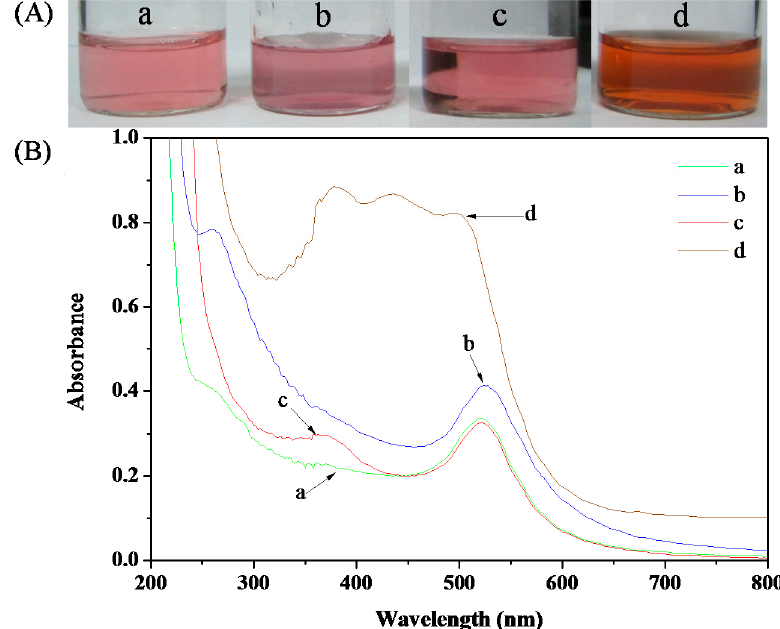
Figure 6. Colorimetric response of the sensor: ( A ) color changes and ( B ) absorption spectra of (a) 1.2 nM citrate-capped AuNPs; (b) 1.2 nM citrate-capped AuNPs with 0.573 mM Ag + ; (c) 1.2 nM HPEI-IBAm functionalized AuNPs; (d) 1.2 nM HPEI-IBAm functionalized AuNPswith 0.573 mM Ag + .